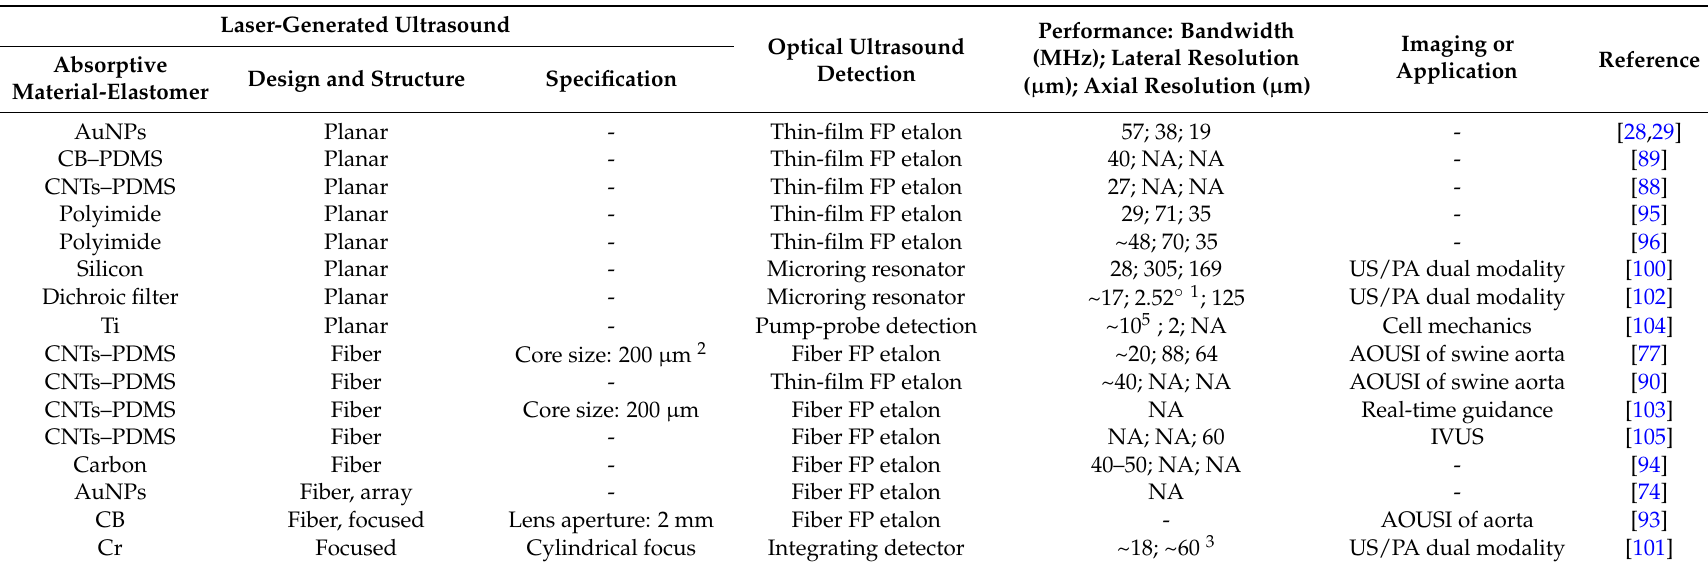
Table A2. Summary of all-optical ultrasound transducers and imaging, AOUSI: all-optical ultrasound imaging; FP: Fabry–Perot; IVUS: intravascular ultrasound; US/PA: ultrasound and